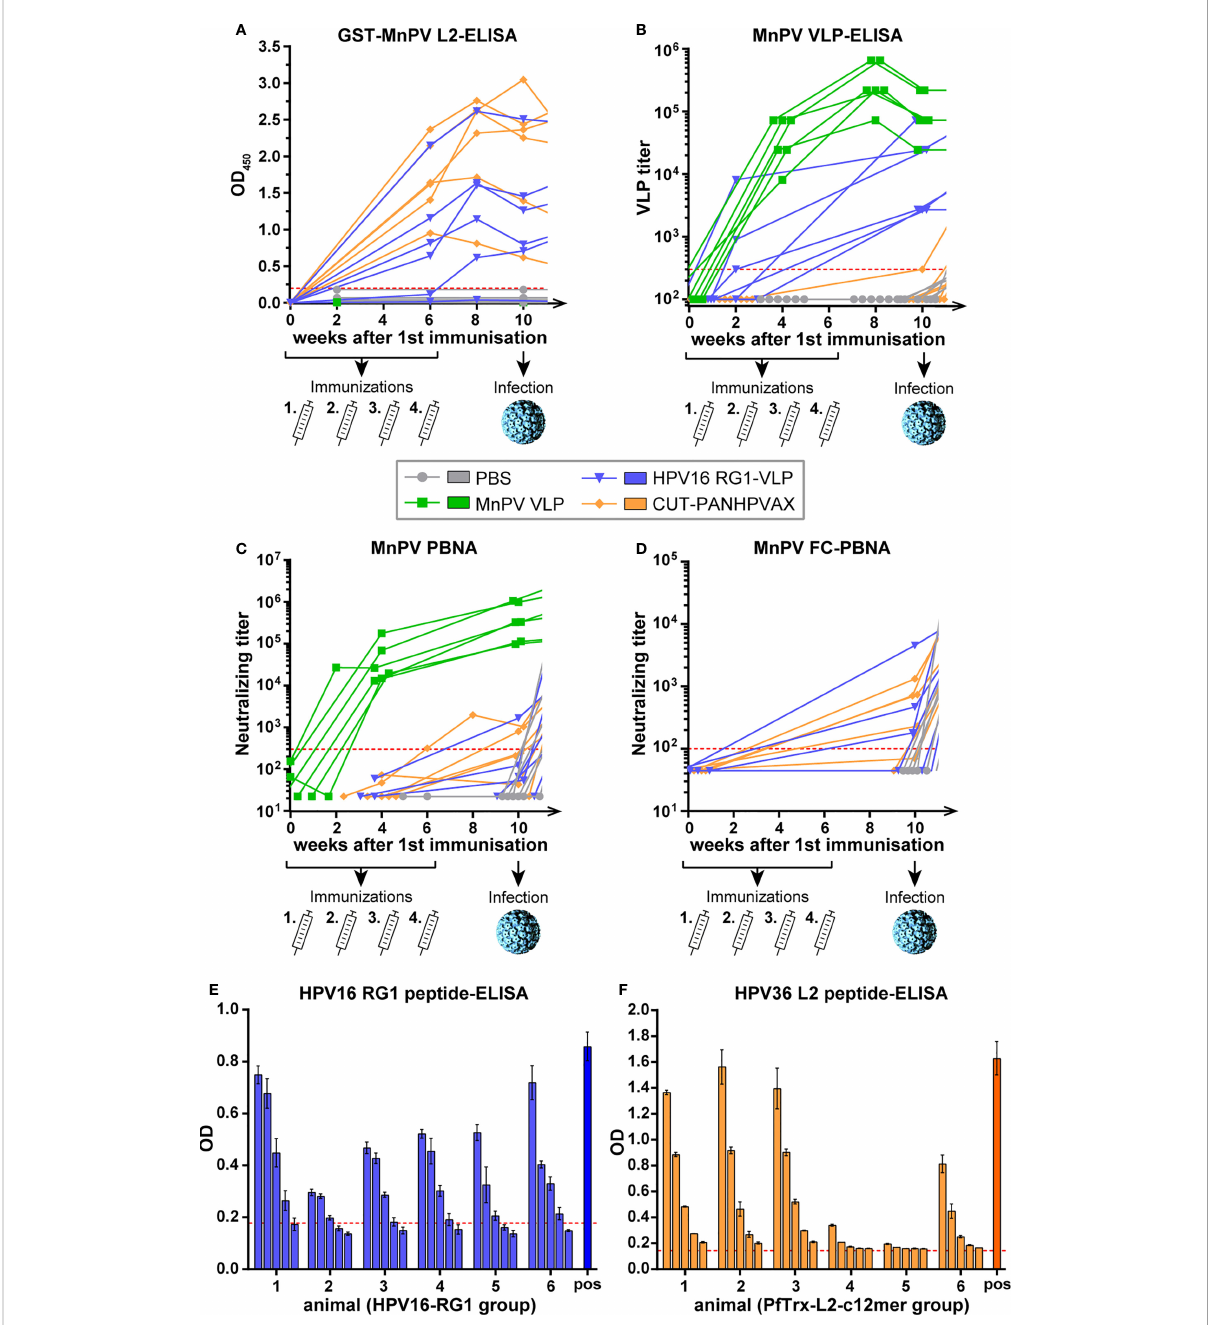
FIGURE 2 Monitoring seroconversion during vaccination. (A) GST-MnPV L2-ELISA. (B) MnPV VLP-ELISA and (C) MnPV PBNA and (D) MnPV FC-PBNA. The animals were vaccinated four times with MnPV VLPs (green), HPV16-RG1-VLPs (blue), CUT-PANHPVAX (orange) or injected with PBS (grey) in a bi- weekly interval from weeks 0 to 6 prior to an experimental MnPV infection at week 10. All groups consist of n=6 animals. Dashed lines represent the methods ’ cut-off (OD 450 = 0.2 for GST-ELISA; titer of 300 for VLP-ELISA and MnPV PBNA or titer of 100 for MnPV FC-PBNA) (Note that VLP sera were not measured in GST-MnPV L2-ELISA and the MnPV FC-PBNA due to limited amount of sera). (E) Sera from the HPV16 RG1-VLP group taken at week 10 were measured as triplicates in serial four-fold dilutions (starting at 1:100) in HPV16 RG1 peptide-ELISA. A HPV16 RG1-VLP raised rabbit serum was used as positive control. Error bars show the standard deviation. The dashed line represents the methods ’ cut-off based on reactivity of PBS animals. (F) Sera from the CUT-PANHPVAX group taken at week 10 were measured as duplicates in serial three-fold dilutions (starting at 1:120) in HPV36 L2 peptide-ELISA. A previously characterized mouse serum raised against HPV38 L2 was used as positive control. Error bars show the standard deviation. The dashed line represents the methods ’ cut-off based on reactivity of PBS